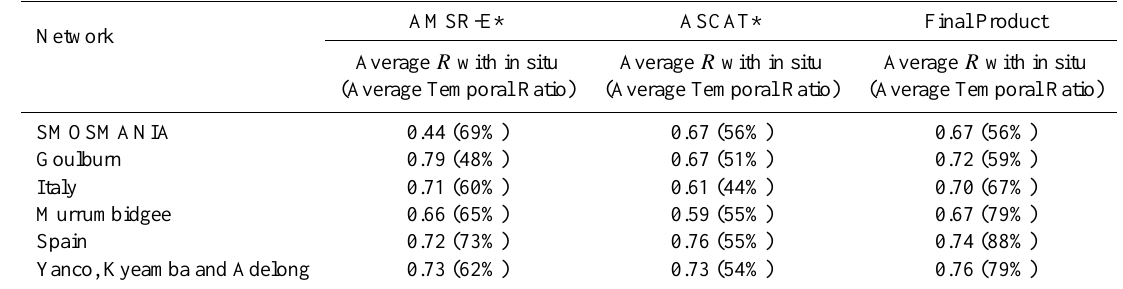
Table 2. Comparisons of overall performance between final merged product and individual products over different in situ soil moisture networks.